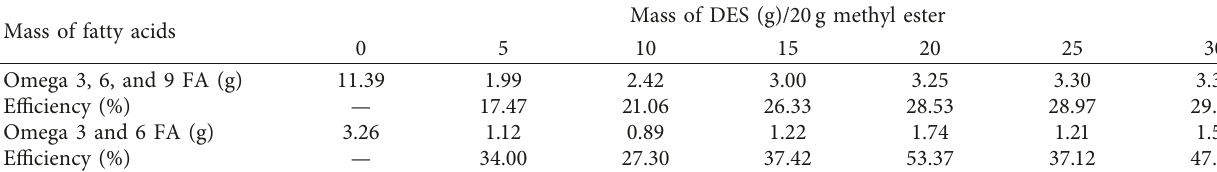
Table 6: The efficiency of omega FA separation from the liquid layer.